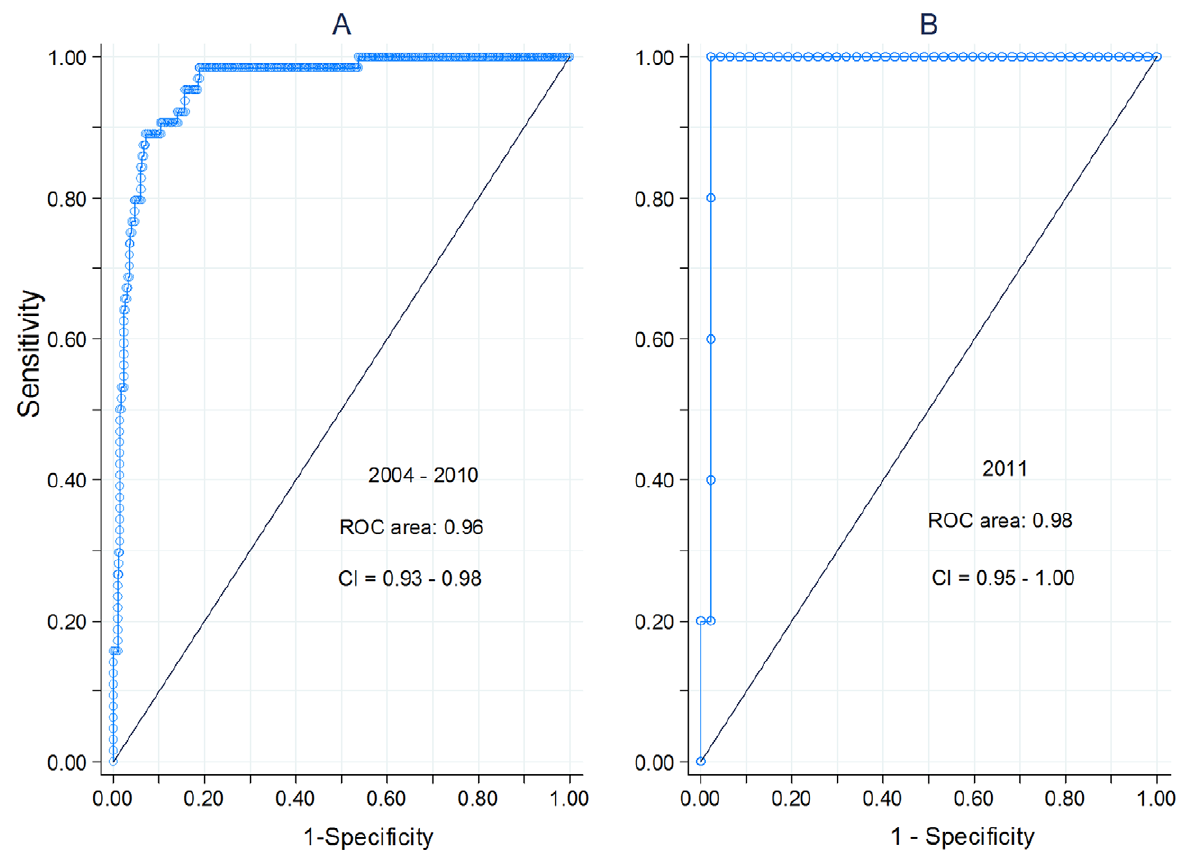
Figure 4. Analysis of sensitivity of model to detect reported dengue epidemics using ROC curves. ROC curves in graph A and B show sensitivity of model to detect true outbreak with corresponding probability of false alarm in year 2004–2010 and 2011, respectively.